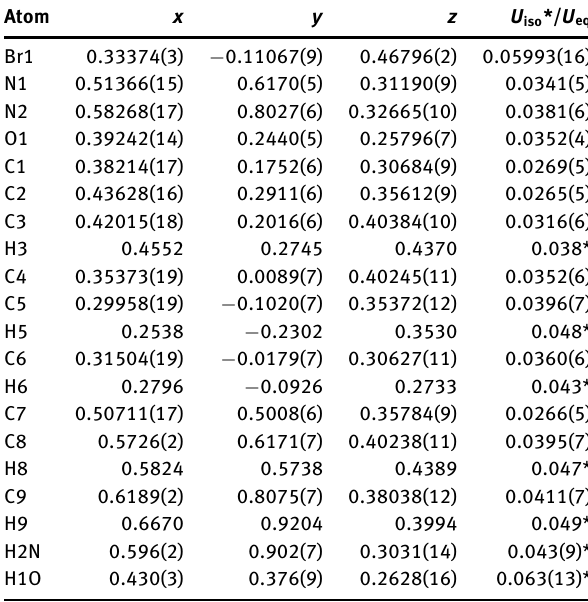
Table 2: Fractional atomic coordinates and isotropic or equivalent isotropic displacement parameters (Å 2